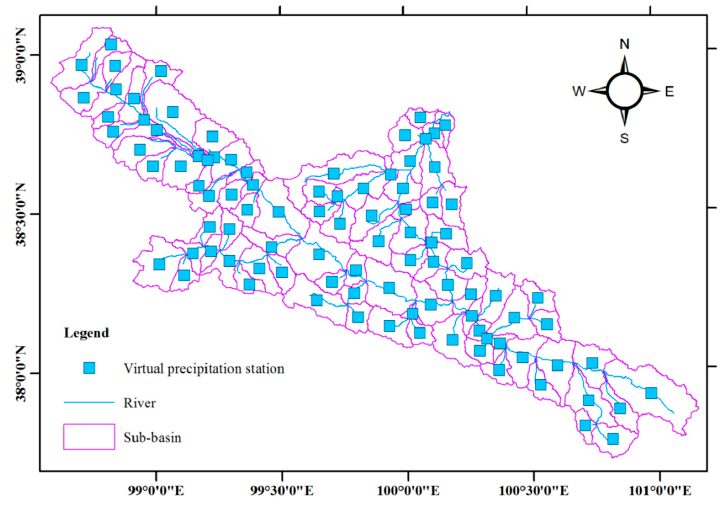
Figure 7. Distribution of the virtual precipitation station.